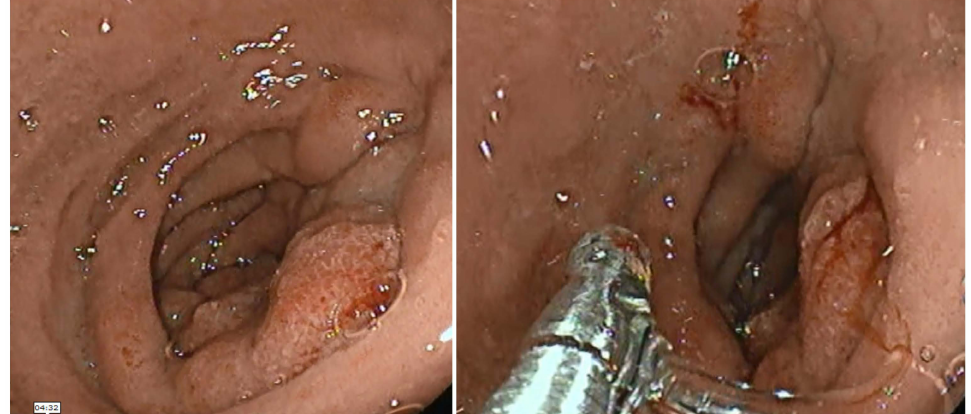
Figure 1. Esophagogastroduodenoscopy revealing an edematous mucosa with a pseudo-polypoid appearance narrowing the second portion of the duodenum.